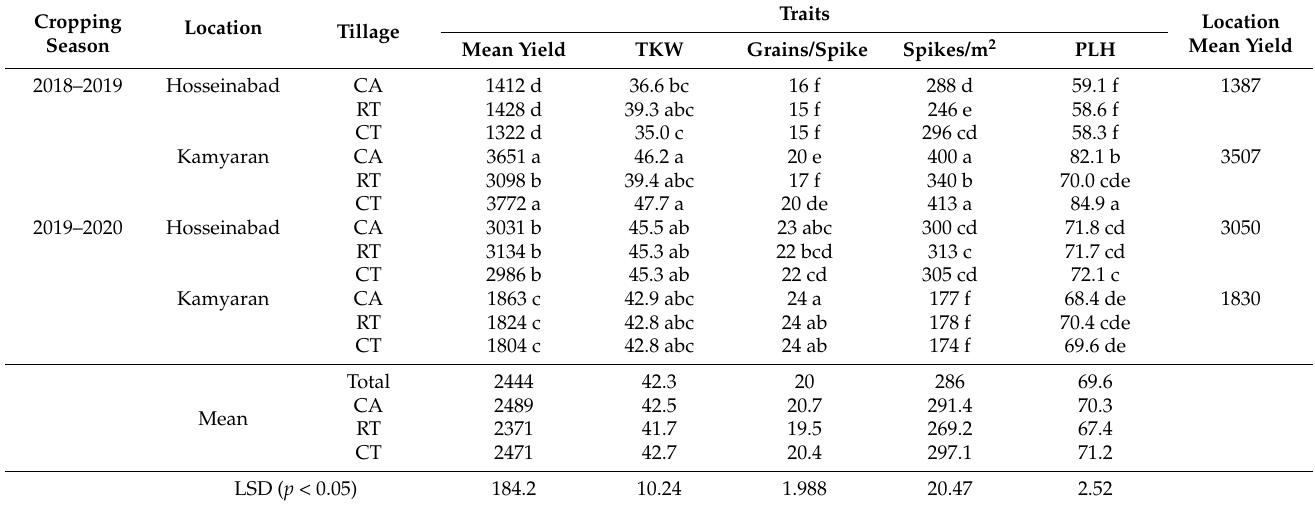
Table 4. Mean performance of wheat genotypes under different tillage systems and location–year combinations for investigated traits of seven barley genotypes under rainfed conditions. The CA, RT and CT stands for conservation agriculture, reduced tillage and conventional tillage,